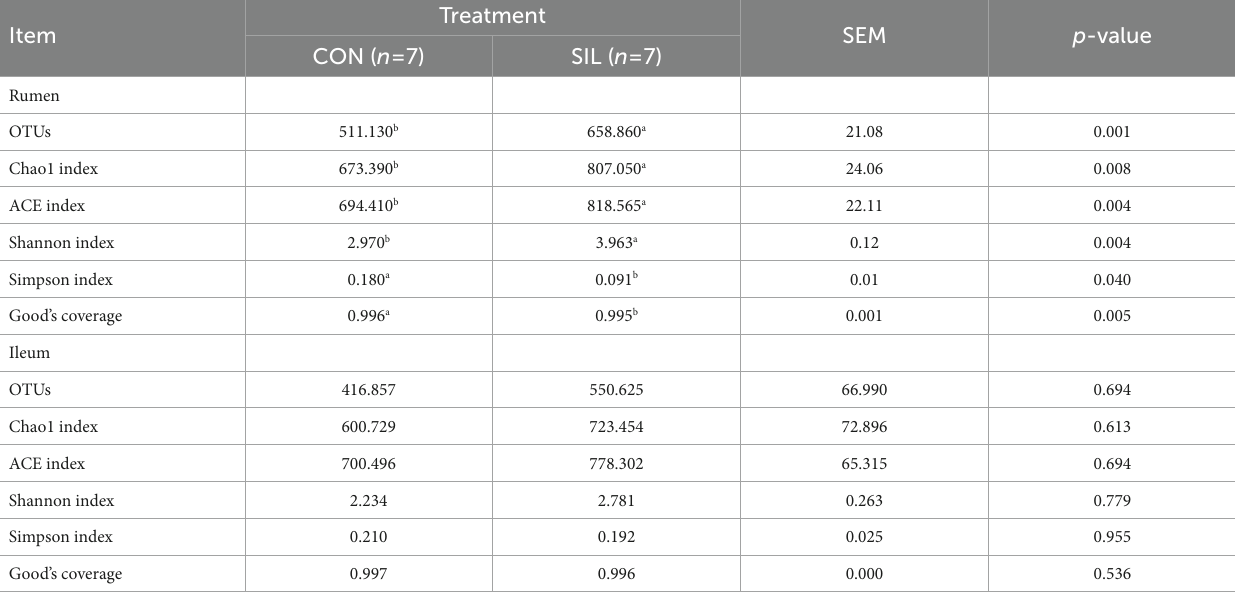
TABLE 5 Effect of silybum marianum meal as a replacement for soybean meal on the alpha diversity index of the rumen and ileum digesta of lambs.